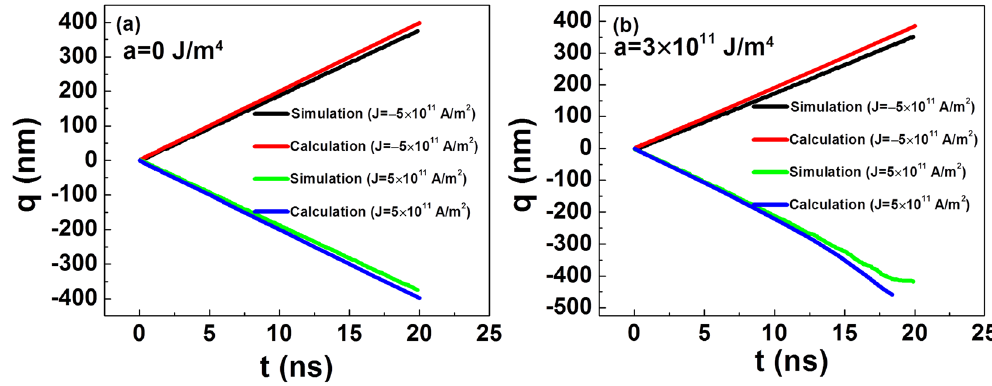
Figure 6. Comparison of numerical calculation and micro-magnetic simulation results for ( a ) a = 0 J/m 4 and ( b ) a = 3 J/m 4